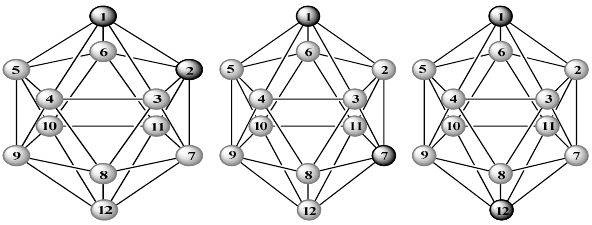
Figure 1. Icosahedral 1,2- closo -C 2 B 10 H 12 , 1,7- closo -C 2 B 10 H 12 ( 1 ) and 1,12- closo -C 2 B 10 H 12 isomers with their vertexes numbering. Dark circles are C c -H vertexes and grey ones are B-H vertexes.